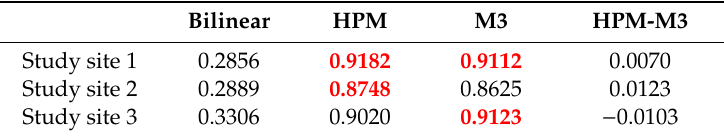
Table 5. Study site Q 2 n values derived considering the six Sentinel-2 20 m sharpened bands (Table 1) together ( n = 6). The highest Q 2 n value (least distortion) for each study site is shown in red bold font, and if values are within two decimal places (i.e., | HPM-M3 | < 0.01), then both are shown in red bold.